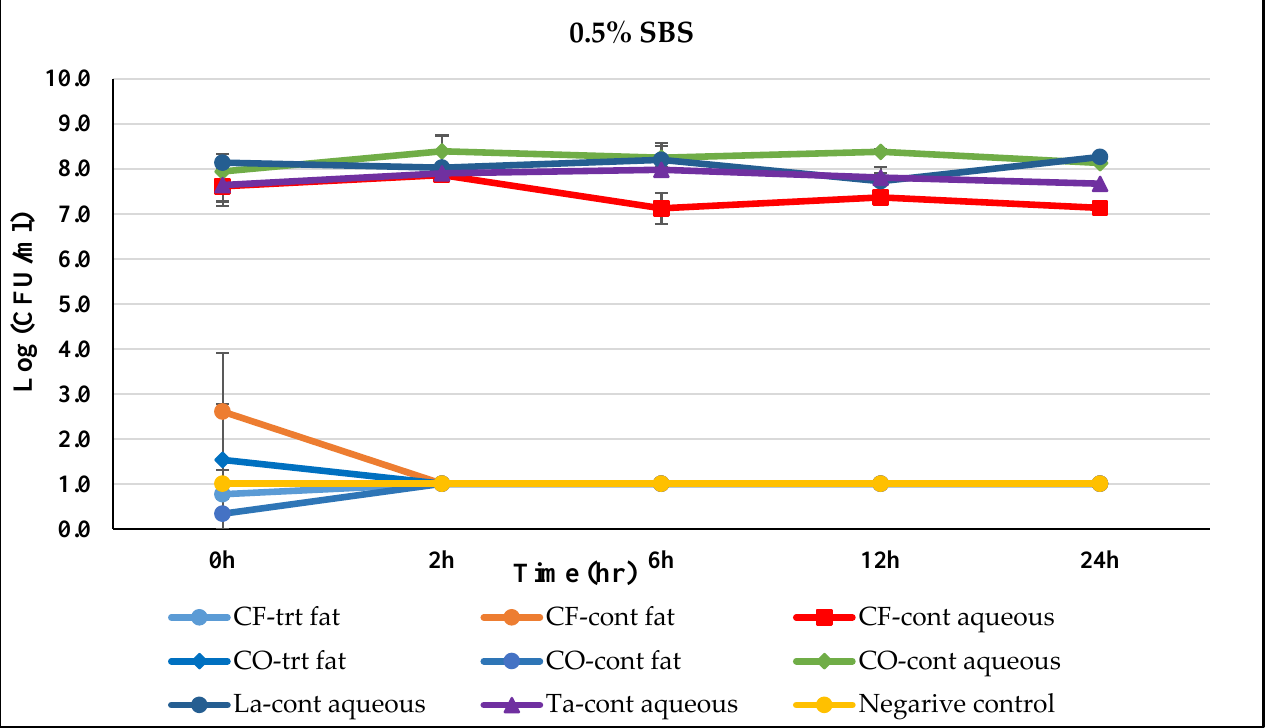
Figure 1. Mean logarithmic counts (log CFU/mL) of Salmonella spp. in different fat and oil systems with and without the inclusion of 0.5% sodium bisulfate evaluated separately for the aqueous phase and fat phase at 45 ◦ C. Treatments from each phase were plated on TSA at different times. SBS, sodium bisulfate; CF, chicken fat; CO, canola oil; La, Lard; Ta, Tallow; Cont., control. Negative control consisted of fat-oil system without an acidulant and Salmonella inoculation. The limit of detection is 1 log CFU/mL for this study. Because the three replications were averaged, for some of the treatments, the counts on 0 h appeared to be lower-than-detection limit. Error bars are ± 1 standard error of the